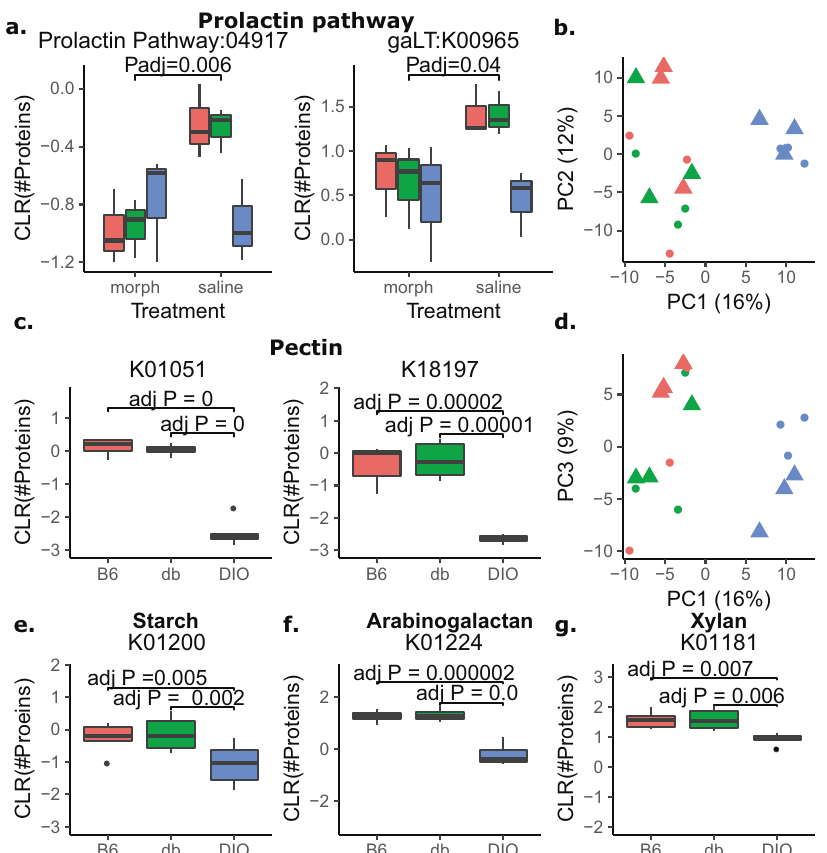
Fig. 4 Total proteins in functional categories reveals functional shifts between morphine versus saline and B6 and db/db versus DIO mice. a Boxplots depicting the difference in relative number of proteins between morphine and saline treated mice in the prolactin pathway and its constituent enzyme gaLT. b , d The fi rst, second and third components of principal component analysis of the number of detected proteins for each KEGG ortholog. c Representative boxplots of the relative number of proteins between lines for KO terms associated with pectin degradation. e – g Representative boxplots of relative number of proteins between lines of KO terms associated with starch, arabinogalactan, and xylan degradation. All boxplots were signi fi cant by two-way ANOVA (Q < 0.25) and TukeyHSD adjusted P value < 0.05, only a single signi fi cant digit